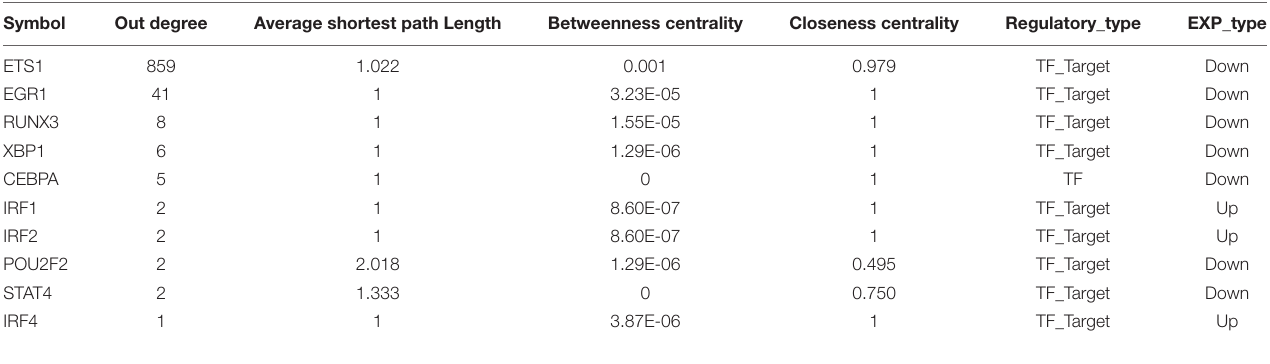
TABLE 2 | Top 10 outdegree genes in the transcriptional regulatory network as key genes. Symbol Out degree